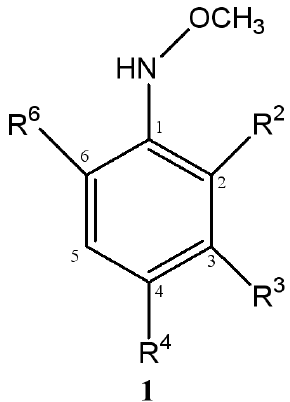
Fig. 1 Structure of N-methoxy-polynitroaniline